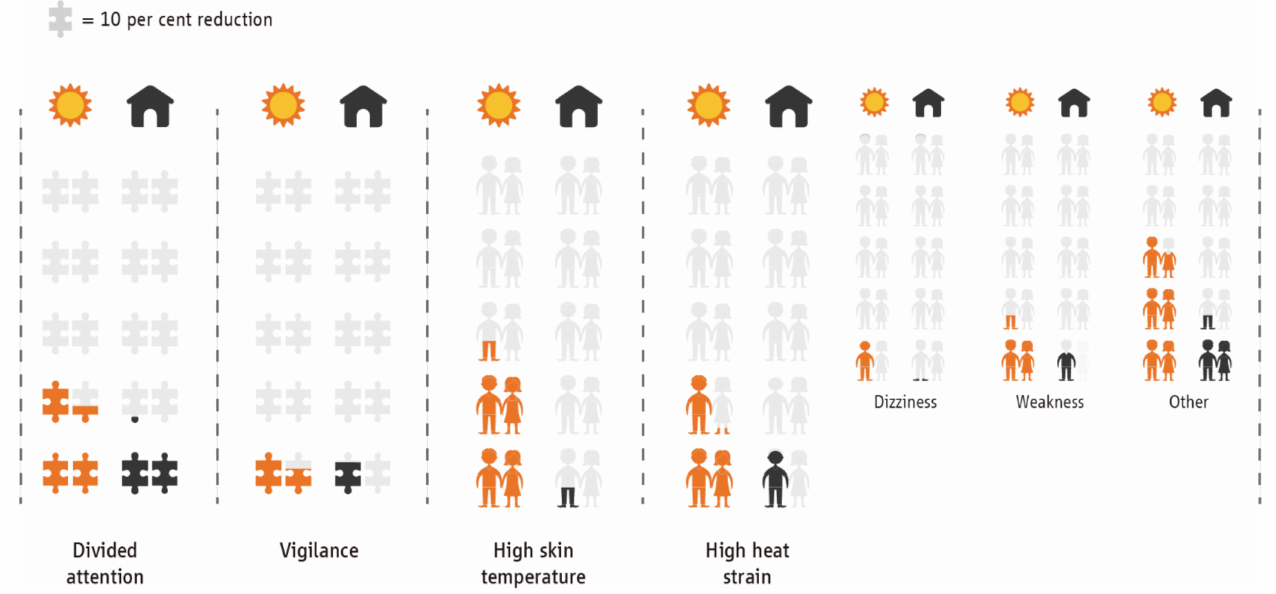
Figure 1. Cognitive and health impacts while working under the sun (left column) and in the shade (right column) in a hot environment (30 ◦ C WBGT). Each full-colored puzzle piece indicates a 10% reduction in cognitive performance (divided attention and vigilance). Each full-colored body figure indicates one-in-ten workers experiencing mean skin temperature higher than 36 ◦ C (the threshold for progressive symptoms of heat strain [14,15]) or danger-level heat strain, including dizziness, weakness, or other